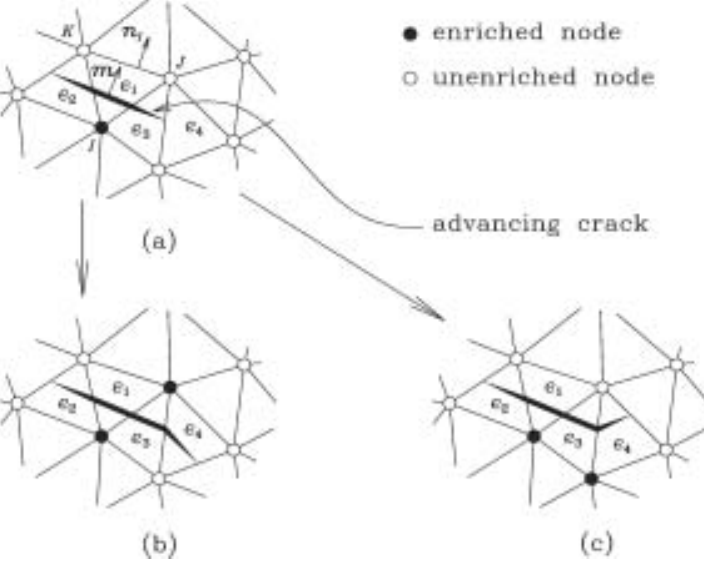
Fig. 3. (a) Crack formation in an element, in which nodes to be enriched depend on the direction of the crack as shown in (b) and (c)..